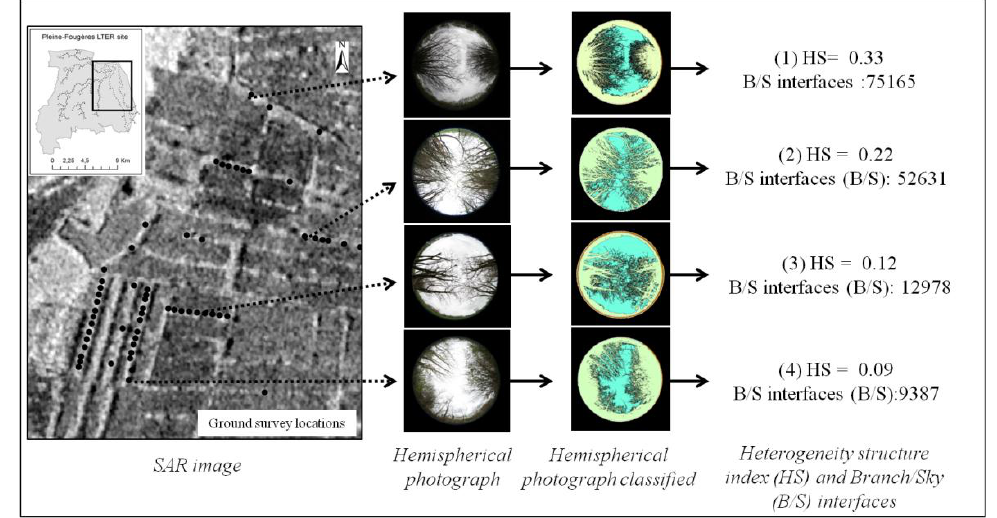
Figure 3. Workflow of field data processing. Legend: ( 1 ) High canopy cover and high fragmentation level; ( 2 ) High canopy cover and medium fragmentation level; ( 3 ) Medium canopy cover and medium fragmentation level; ( 4 ) Low canopy cover and low fragmentation